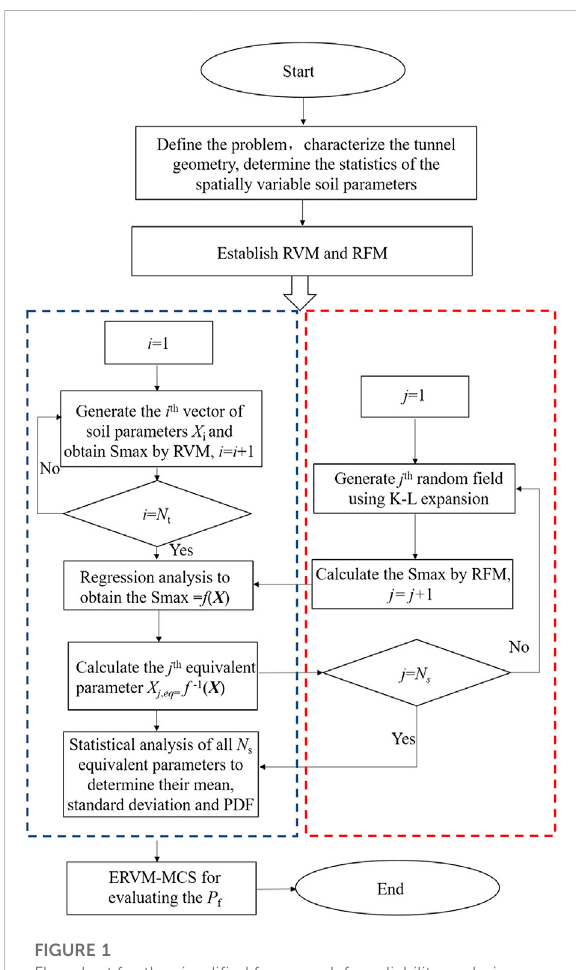
FIGURE 1 Flowchart for the simpli fi ed framework for reliability